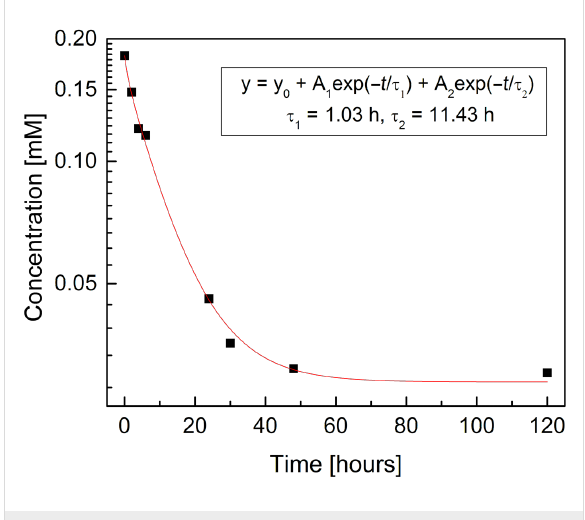
Figure 4: Deposition kinetics of PEMPDA- β -CD onto Nafion ® 117 as obtained from ELSD detection of the decreasing concentration in the